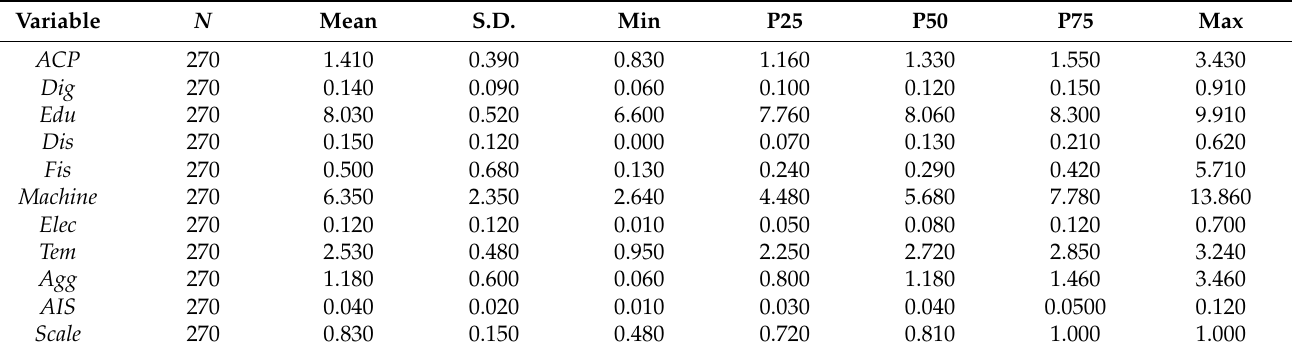
Table 4. Descriptive